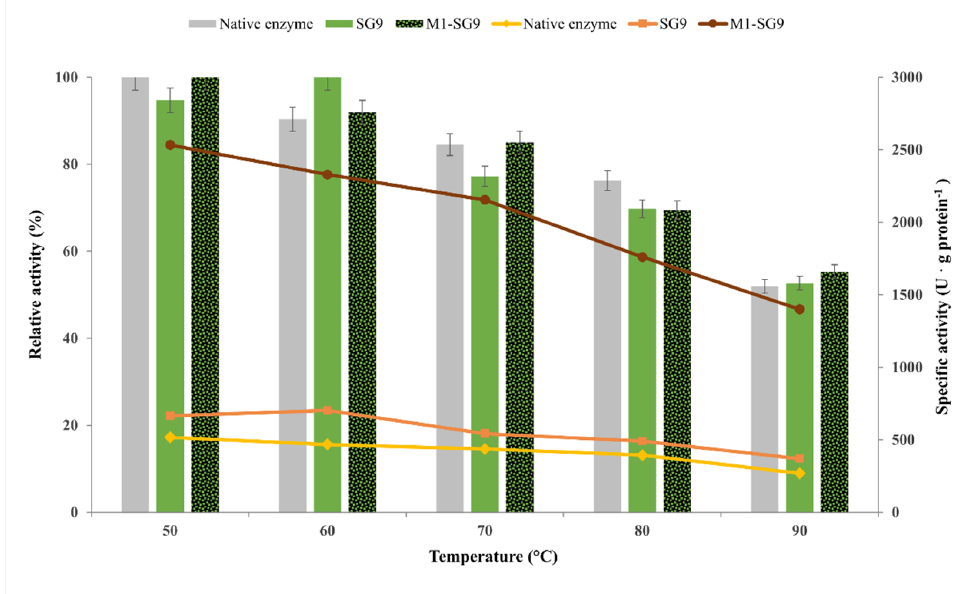
Figure 11. Influence of temperature on the catalytic efficiency of native and immobilized Cellic CTec2 cellulase by entrapment in sol–gel (SG9) and magnetic sol–gel (M1-SG9) with VTMOS:PhTMOS:TMOS (0.4:1.6:1) in the hydrolysis of CMC at 30 min reaction time and different temperatures in the range 50–90 °C.